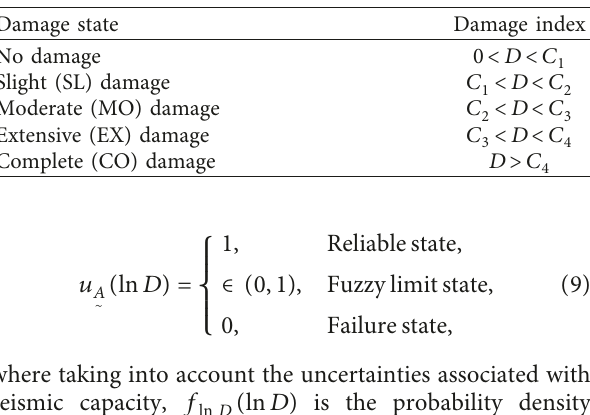
Table 1: Relationship between damage state and damage